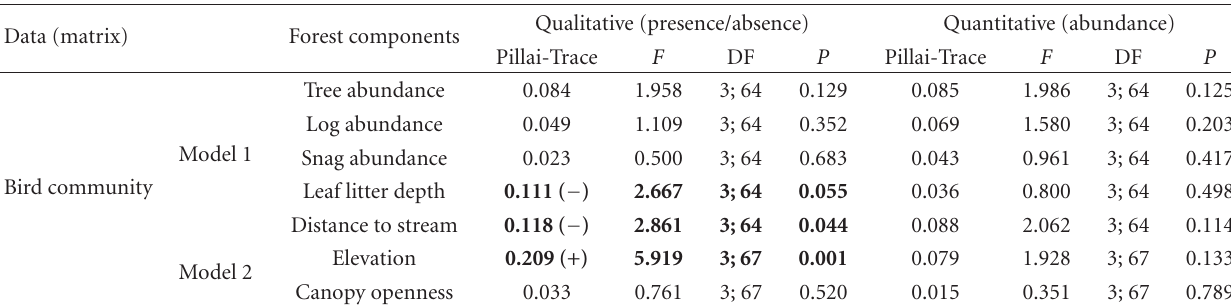
Table 3: Results of the multiple regression analyses performed to test the e ff ect of the seven forest structure components on qualitative and quantitative bird composition. Analyses were performed on scores from the Principal Coordinate Analyses